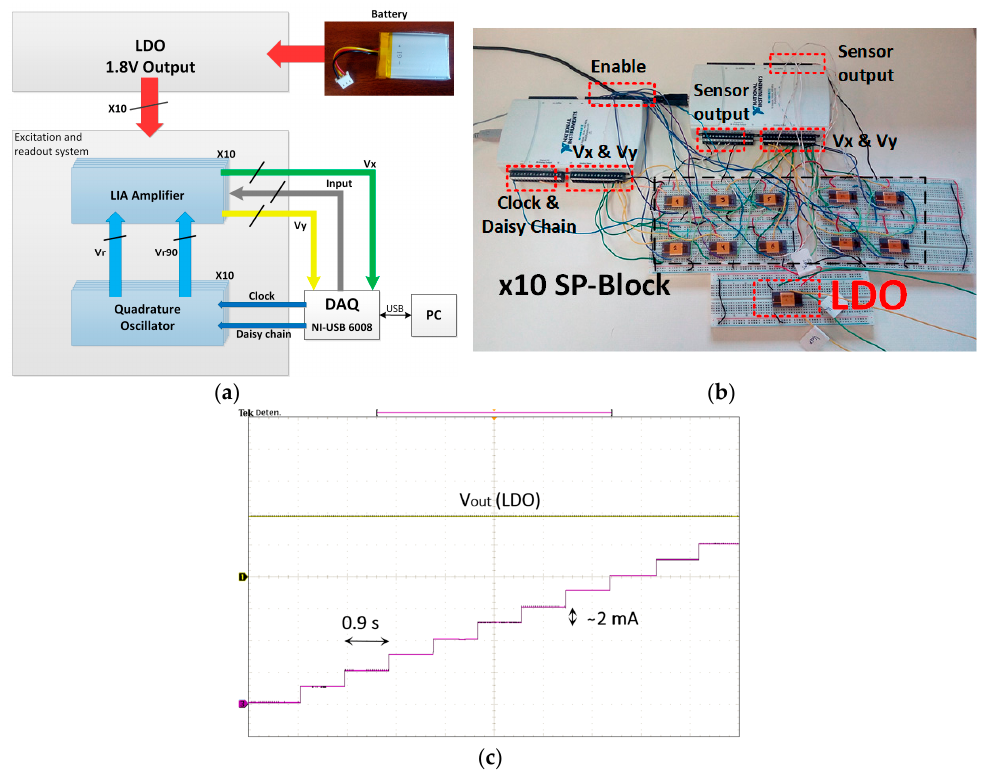
Figure 15. Multichannel LIA-based battery supplied micro-instrument: ( a ) Implementation; ( b ) block diagram; and ( c ) oscilloscope screenshot for the application of (green) LDO output voltage and (purple) activation of each signal-processing block.